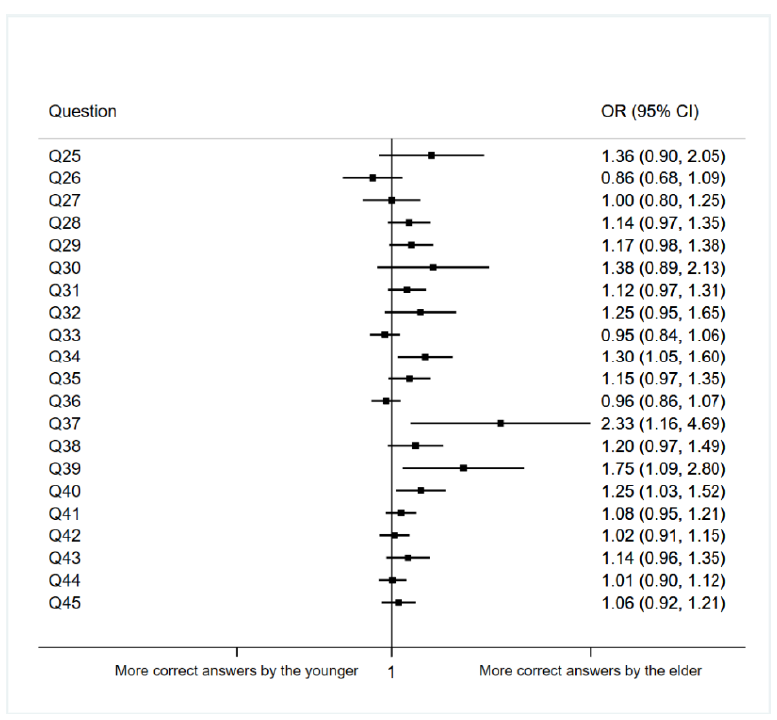
Figure 1. Association between questions regarding students’ opinions and age (per year).